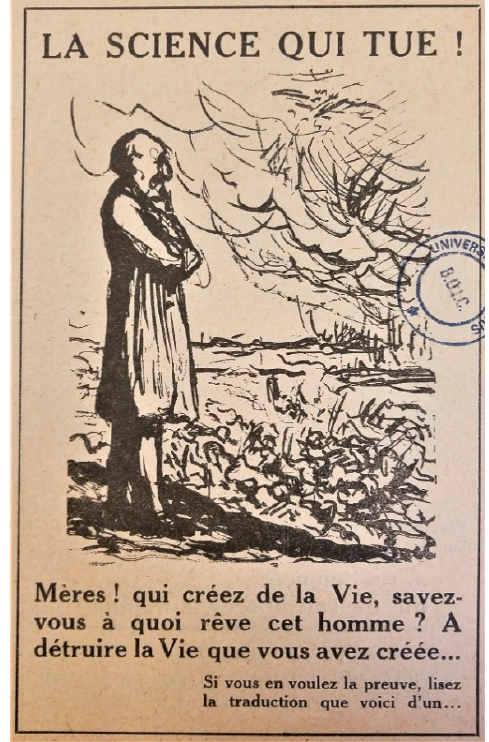
Figure 12. “The science that kills. Mothers who create life, do you know of what this man dreams? To destroy the life you have created….” Ink on paper. La Contemporaine. Fonds Duchêne. F Δ res 0235. Box 4. Folder 18.